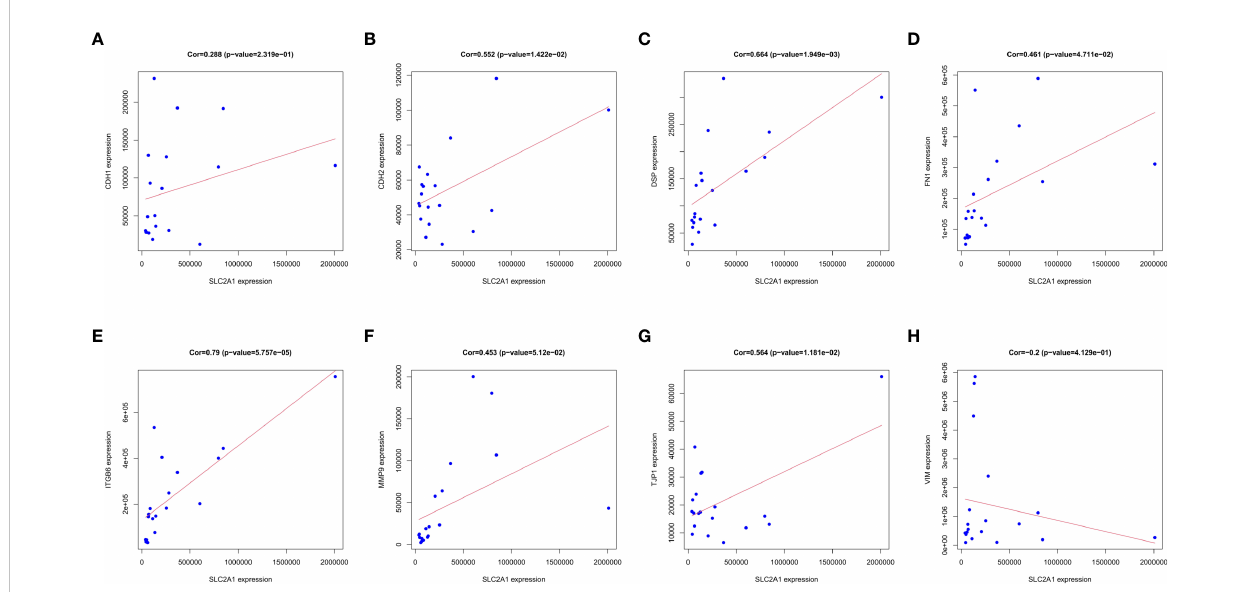
FIGURE 8 Correlation between SLC2A1 expression and EMT markers in proteomics: (A) CDH1; (B) CDH2; (C) DSP; (D) FN1; (E) ITGB6; (F) MMP9; (G) TJP1; (H) VIM.